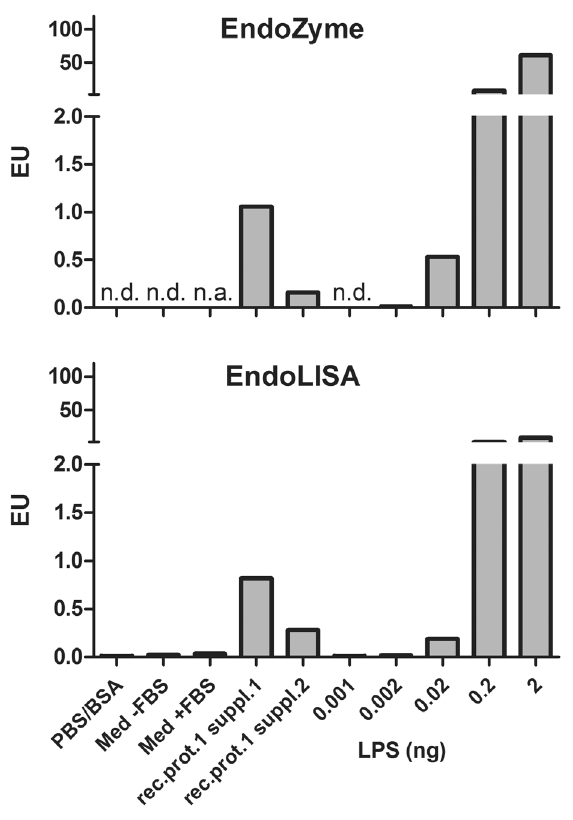
Figure 1. Analysis of endotoxin contents by two commercially available endotoxin detection assays. Endotoxin contamination levels of recombinant protein 1 from suppliers 1 and 2 were measured by EndoZyme and EndoLISA. Results show impurities in 1 m g of recombinant protein 1 from two different suppliers (rec.prot.1 suppl.1 and rec.prot.1 suppl.2). As controls, total amounts of 0.001–2 ng E.coli LPS, as well as solvent (PBS containing 0.1% BSA, undiluted), DC-medium without FBS (Med –FBS) and with FBS (Med + FBS; both diluted 1:10 in endotoxin-free water) were used. Results show mean values of technical duplicates. n.d., not detectable; n.a., not